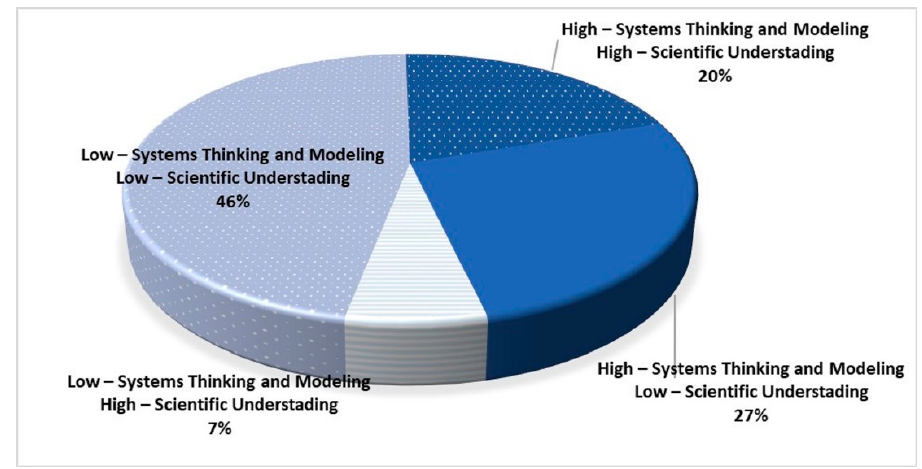
Figure 5. Distribution of students’ skills levels (N = 15).